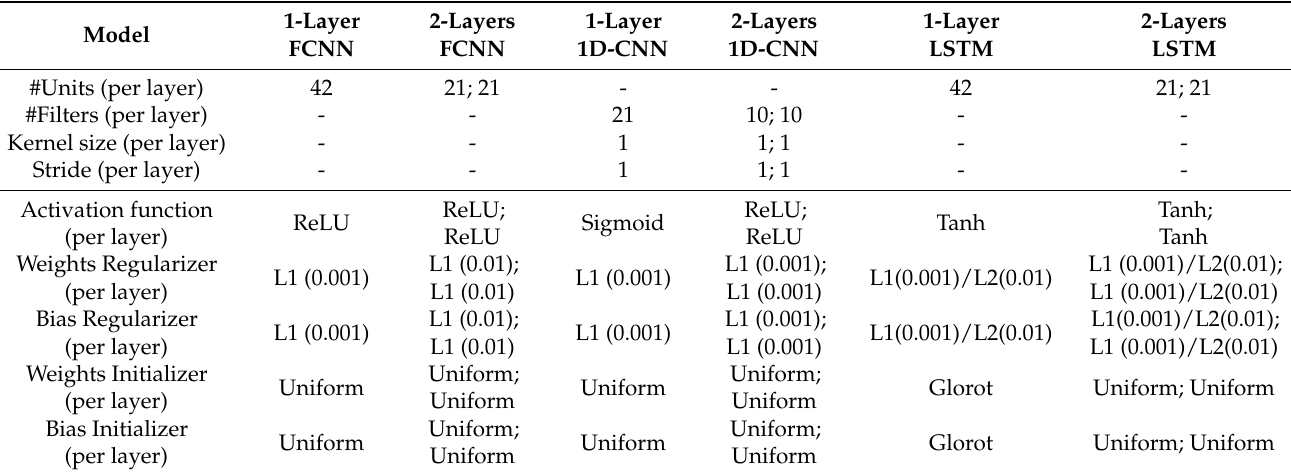
Table 1. Design details of the